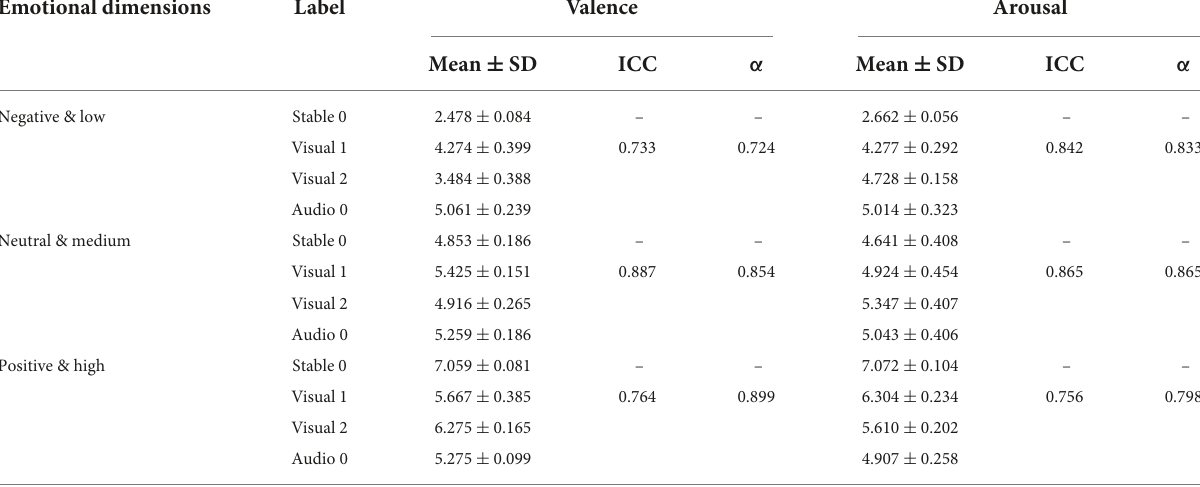
TABLE 7 Evaluation results of multimodal database of valence & arousal